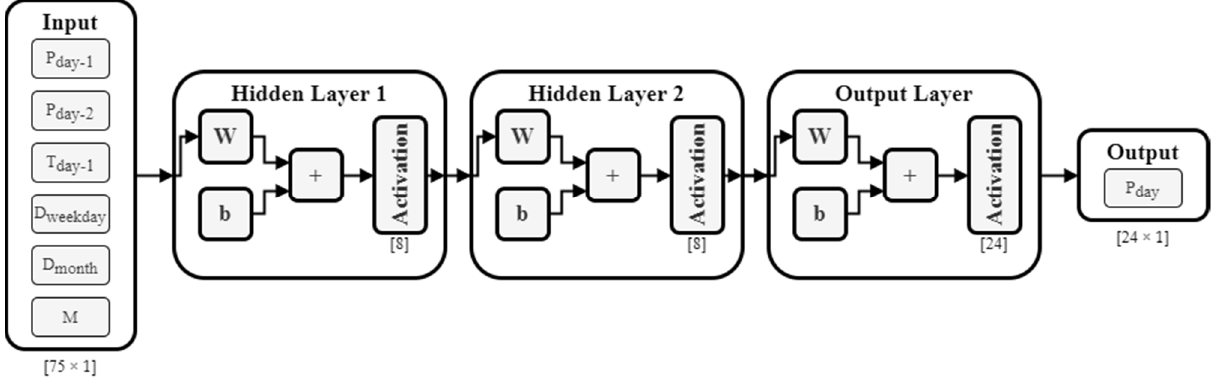
Figure 2. Neural network for load demand forecasting at Dansmästaren.